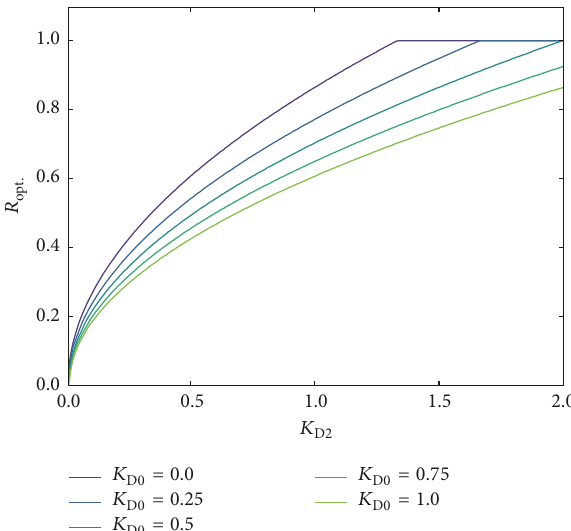
Figure 12: The optimum actuator size ratio 𝑅 to a Pmax . maximum hydraulic power density (1/𝑅)𝐶 function of the drag coefficient 𝐾 drop coefficient 𝐾 when D 2